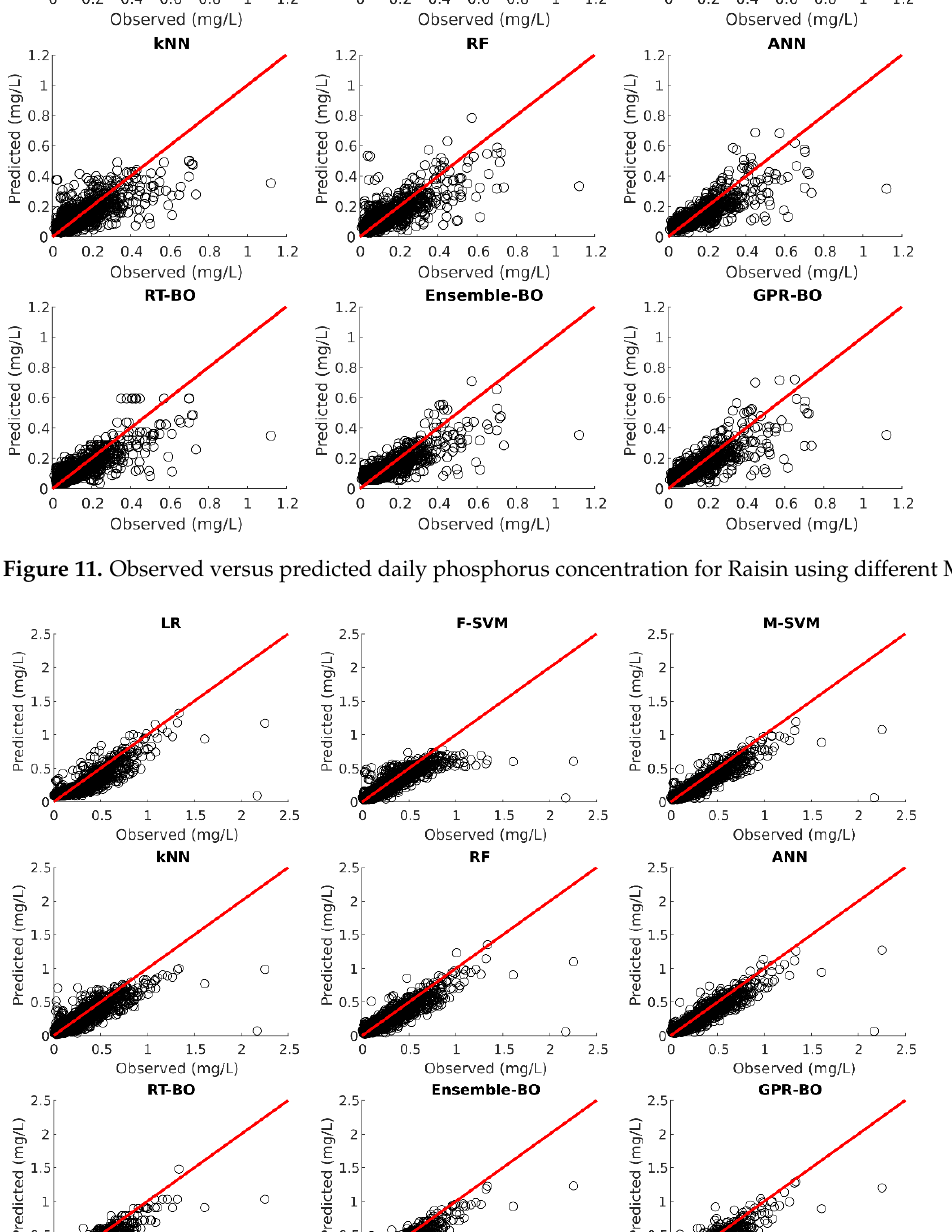
Figure 12. Observed versus predicted daily phosphorus concentration for Sandusky using different ML algorithms.